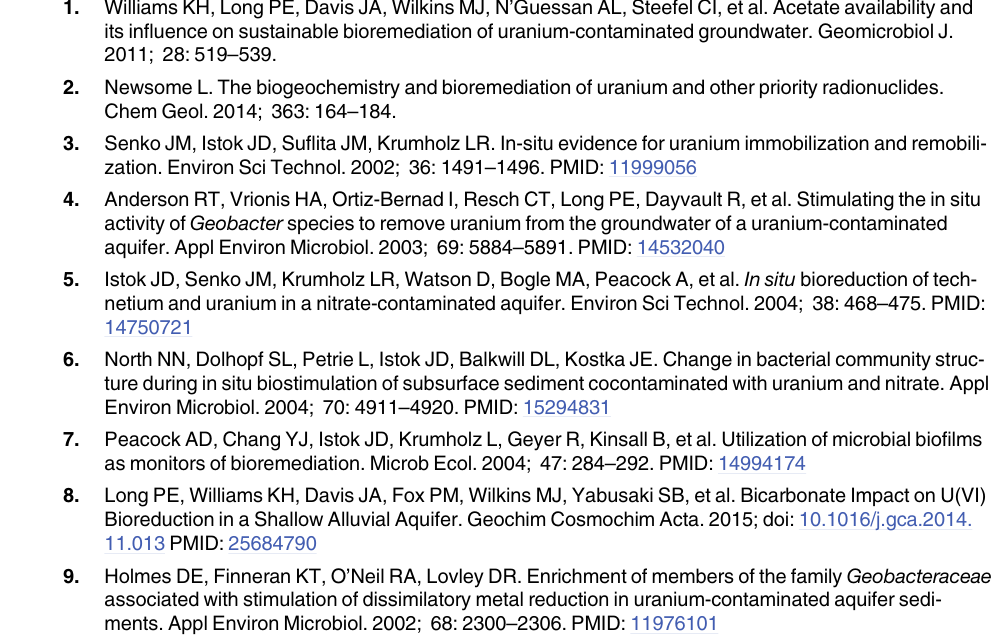
S2 Fig. Average proportion of soluble and insoluble uranium over time with uranyl acetate addition (5 and 10 μ M) measured by ICP-mass spectrometry. (TIFF) S3 Fig. Uranium solubility when anaerobic culture samples are filtered under oxidizing conditions. (TIFF) S4 Fig. Changes in cell number in replicate microcosms with various terminal electron ac- ceptors after a 5-day incubation. Cells were grown in M9 media with 0.4% dextrose as an elec- tron donor and the terminal electron acceptor indicated. Error bars indicate the variability (SD) in the cell counts for each microcosm. The inset is the anaerobic incubations on a different scale.